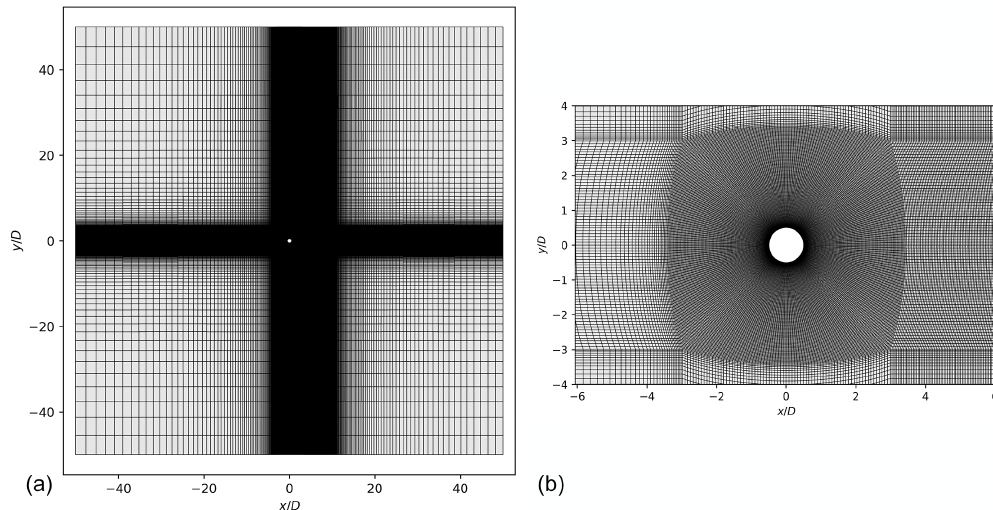
Figure 3. Computational mesh: full domain (a) , zoom around the cylinder (b) .